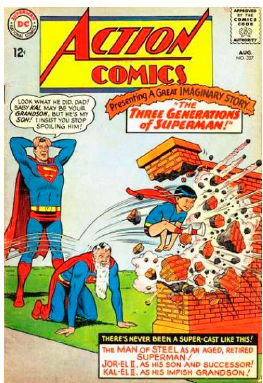
Figure 5. Action Comics #327, “The Three Generations of Superman” (August 1965) [10] .